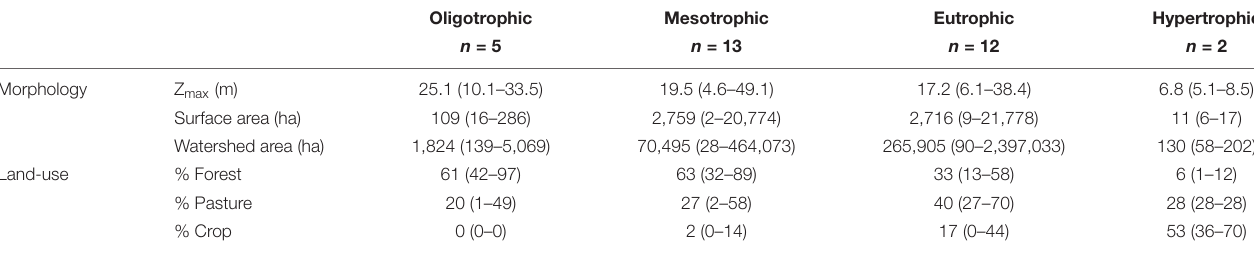
TABLE 3 | Morphology and watershed land-use describing the 32 reservoirs sampled during the 2-year study